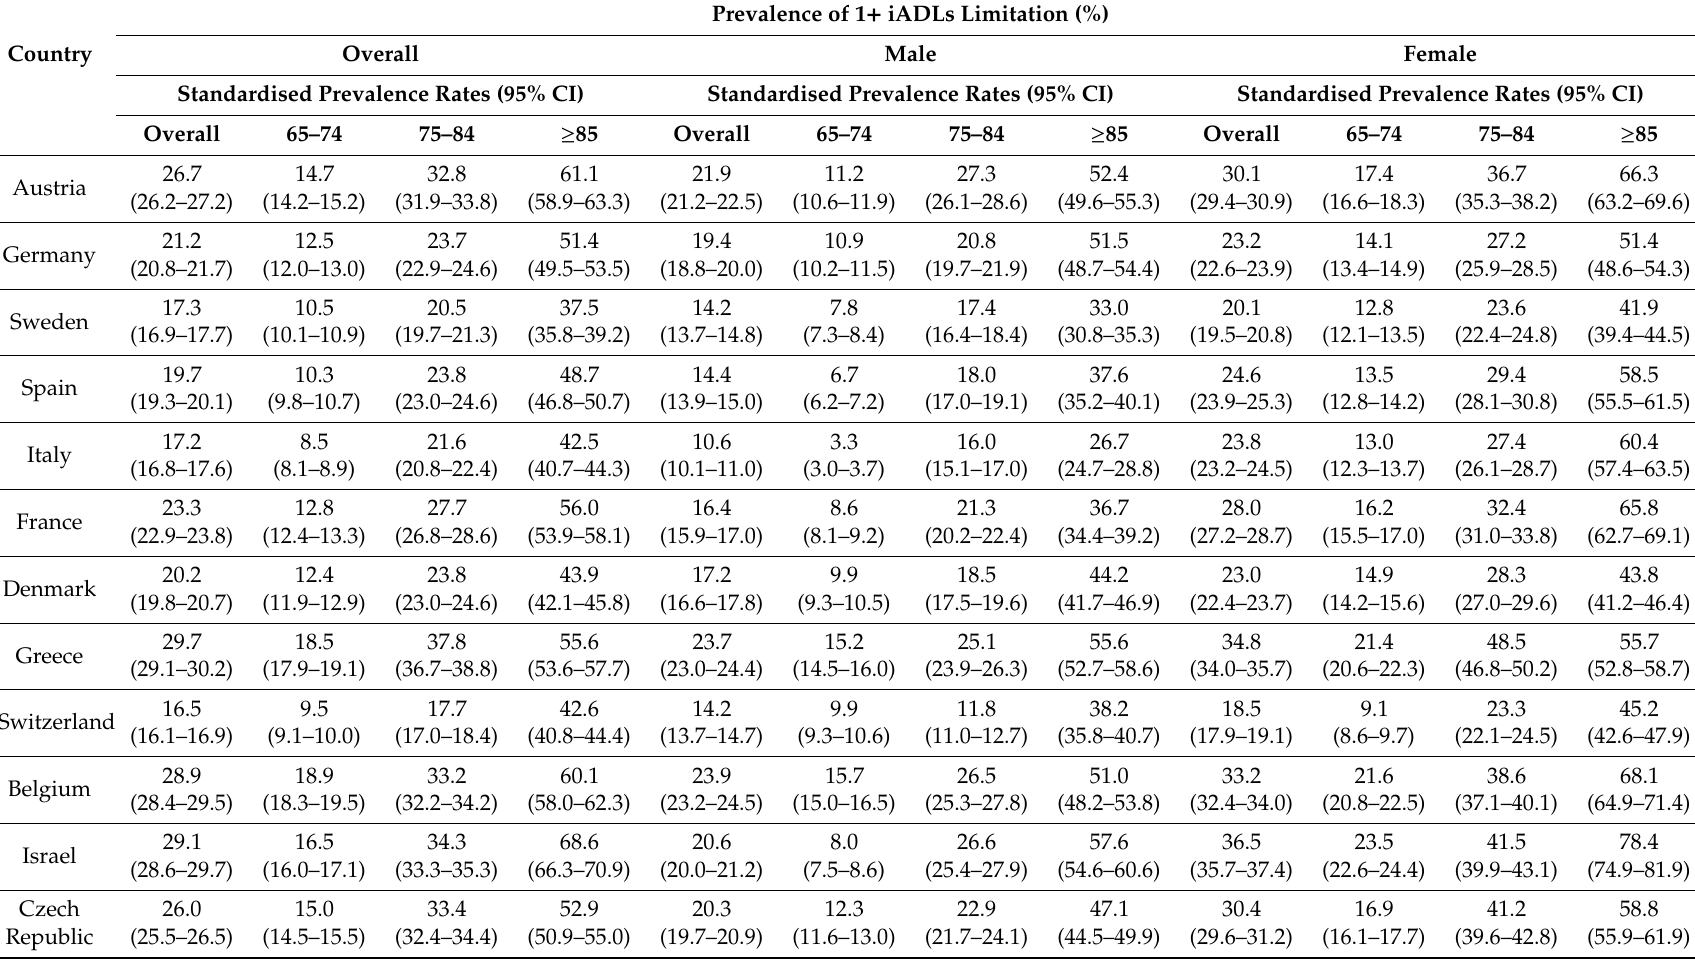
Table 1. Prevalence of one or more iADLs limitation according to country, gender, and age group. iADLs (Instrumental activities of daily living); CI (confidence